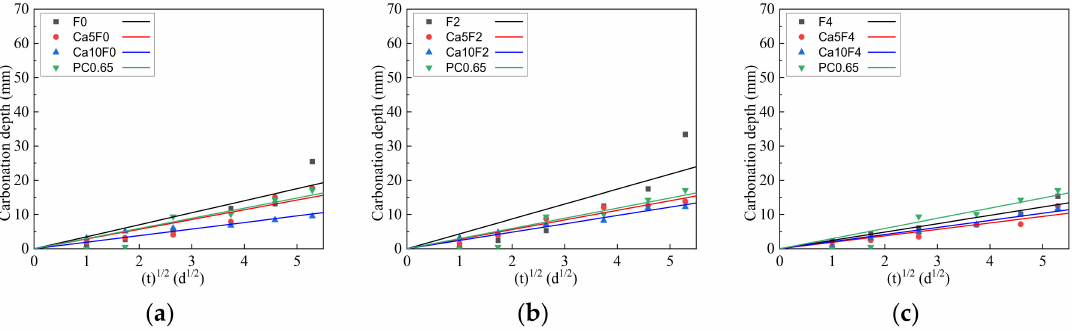
Figure 4. The fitting curve of carbonation depth of cement and geopolymers. ( a ) F0; ( b ) F2; ( c )